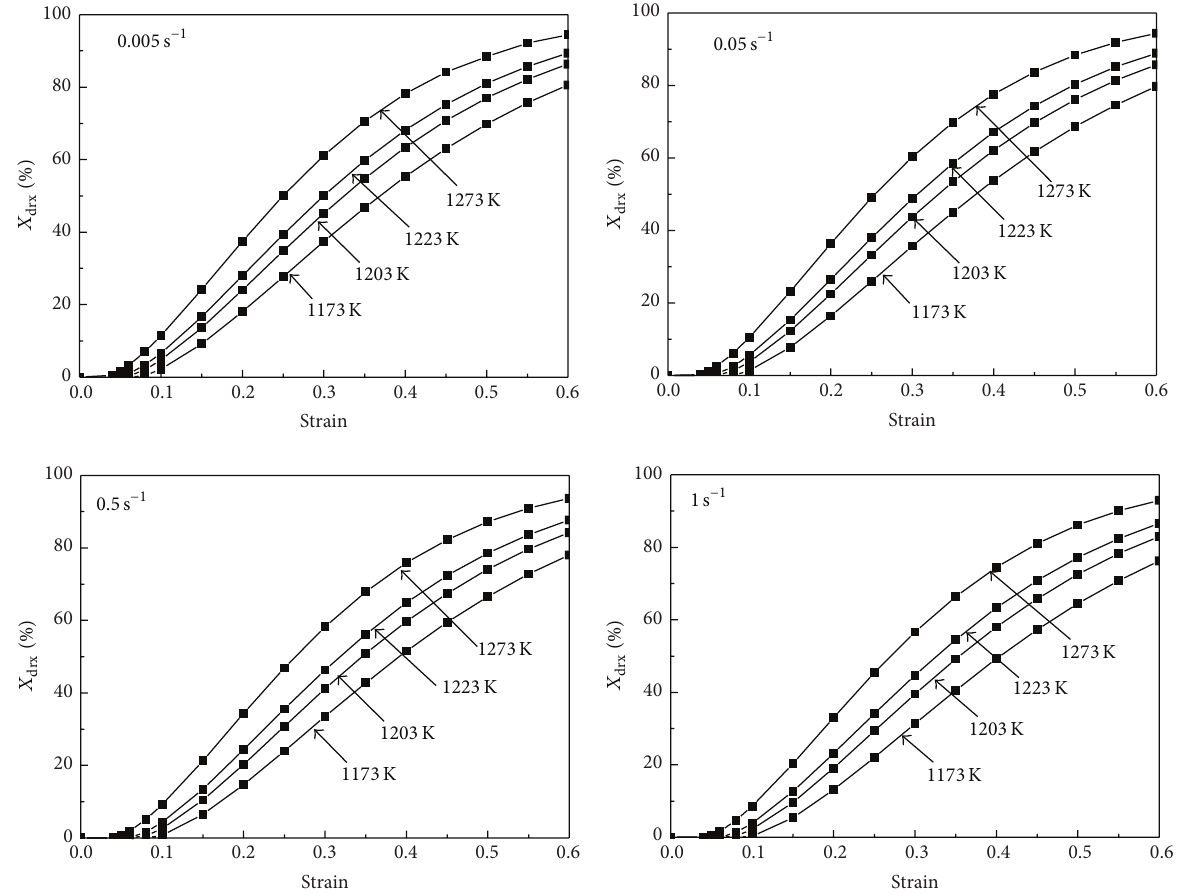
Figure 12: Predicted DRX volume fractions of TA15 at different